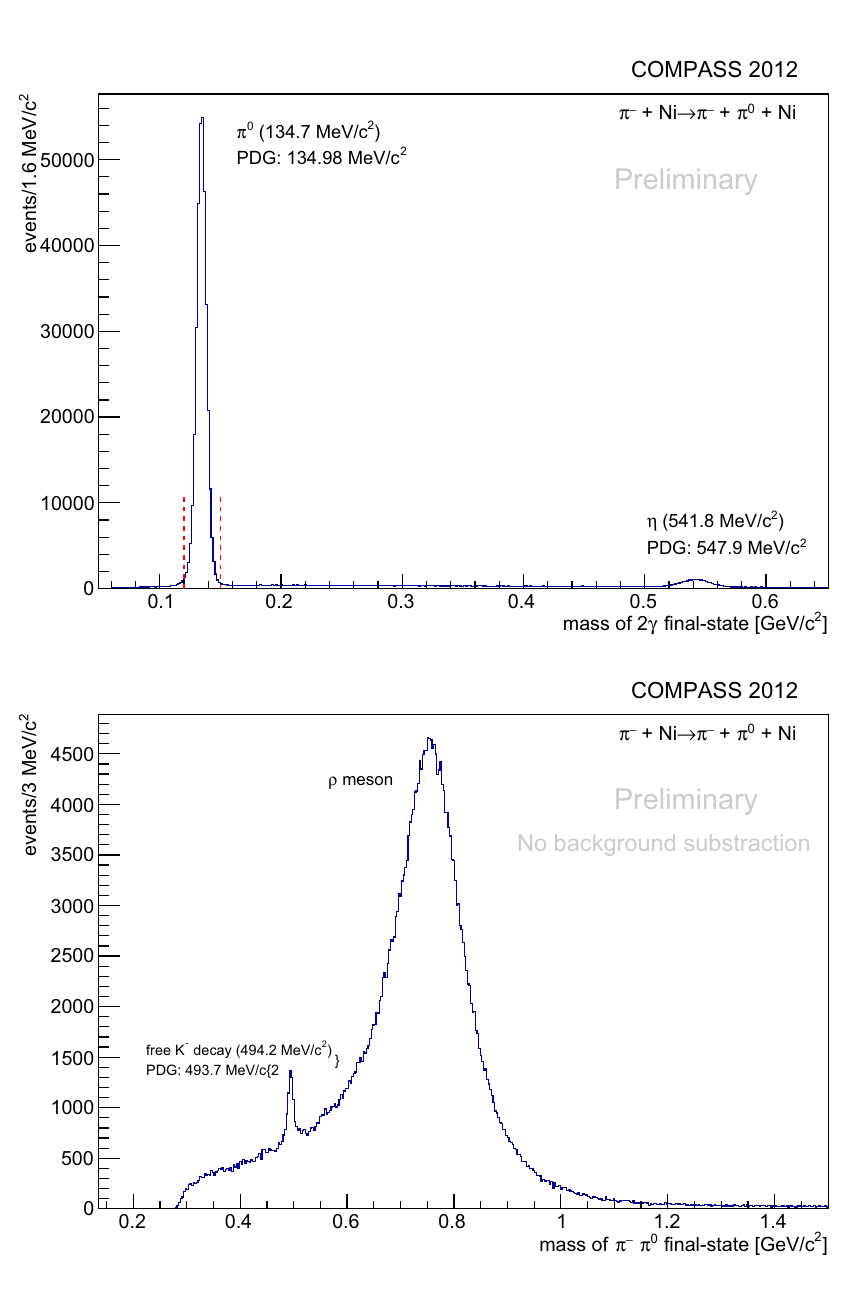
Figure 2. Kinematic selection of the process π − γ → π − π 0 . Upper plot: Invariant-mass spectrum of the two final-state photons, featuring peaks at the nominal π 0 and η masses. The peak corresponding to π 0 production is selected for the further analysis. Lower plot: Invariant mass of the final state π − π 0 , before background subtraction. The peak of the ρ (770) resonance is salient, the interpretation of the further details of the spectrums can however only be done after background subtraction. Due to the 2.5% kaon fraction in the incoming beam, a peak from in-flight decays K − → π − π 0 is also